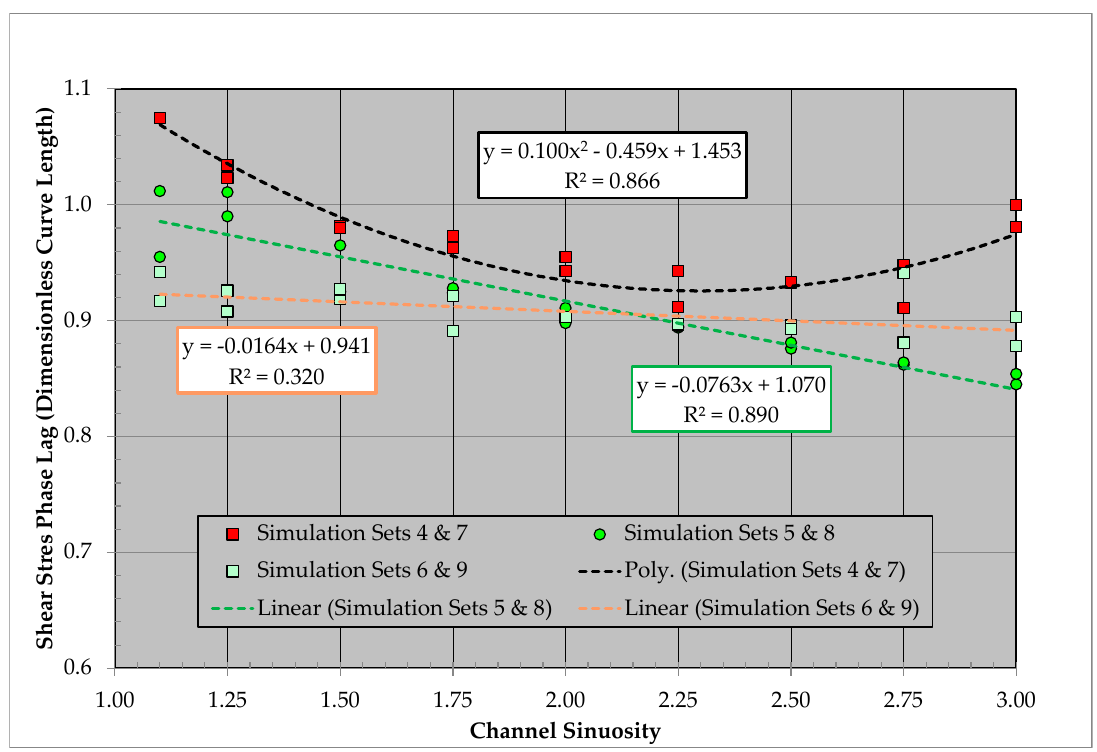
Figure 47. Correlation of dimensionless shear stress phase lag and channel sinuosity using data from all 6 simulation sets.